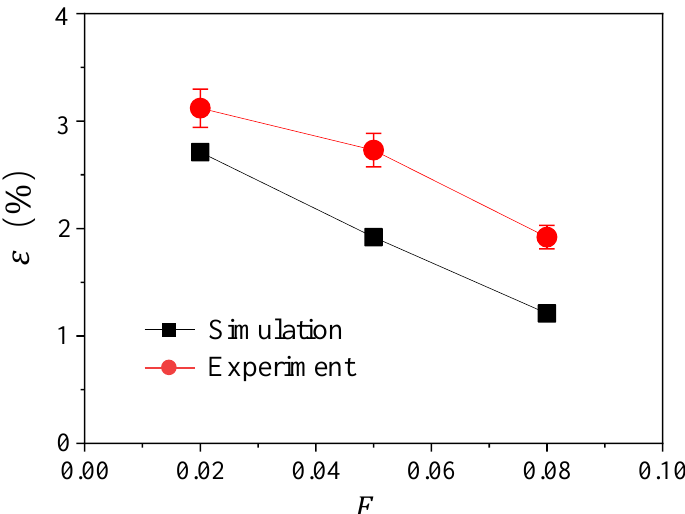
Figure 5. The variation of particle capture efficiency ε with blowing ratio F for experiment result and simulation